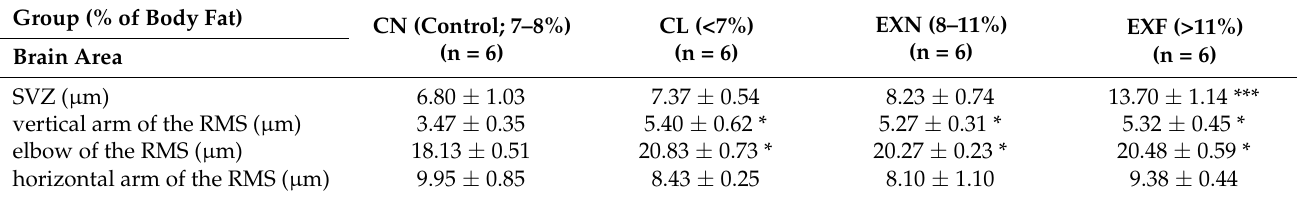
Table 1. Thickness of the SVZ/RMS in mice with various body conditions.